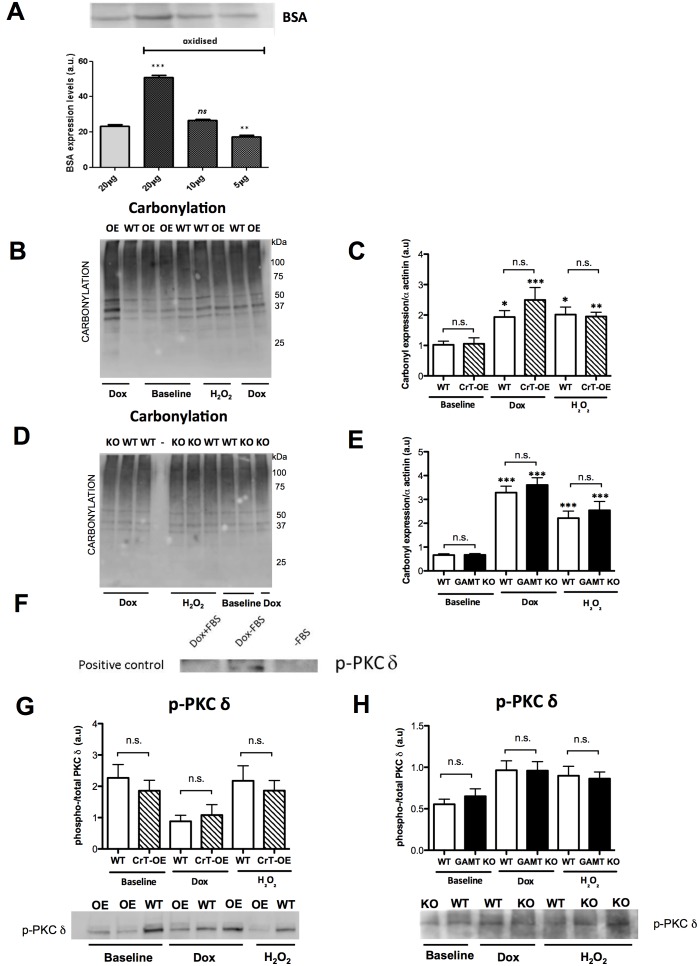
Analysis of phosphorylated PKC δ and carbonylation protein profile in response to acute oxidative stress.(A) Oxidized bovine serum albumin (BSA) control demonstrating sensitivity of the assay to detect differences in protein carbonylation. ***P<0.0001 **P = 0.008 ns: non-significant. Profile of total carbonylation levels in DNPH-derivatised mouse LV tissue using immunoblotting and probing vs DNPH. Representative blots of (B) Wild-type (WT), CrT-OE (OE) and (D) GAMT KO (KO) and wild-type (WT). (C) Expression of ROS-induced protein damage in lysates of CrT-OE vs WT (E) GAMT KO vs WT at baseline, after exposure to doxorubicin hydrochloride (Dox) and H2O2. (F) Representative blot of doxorubicin-treated MCF-7 cells used as positive control displayed increased p-PKC δ levels (Dox–FBS) versus untreated cells (Dox+FBS, –FBS). Phosphorylated PKC δ band was obtained only in the FBS pre-starved cells that were subsequently exposed to Dox. (G) Expression of p-PKC δ in CrT-OE vs WT and (H) GAMT KO vs WT hearts at baseline, after Dox or H2O2 treatment [figure includes representative p-PKC δ western blot images for sample groups as above]. Data mean±S.E.M. CrT-OE (n = 5) WT (n = 6) GAMT KO (n = 6) WT (n = 5). *P<0.05, **P<0.01, ***P<0.001 for comparison with baseline values for same genotype by one-way ANOVA with Bonferroni correction.